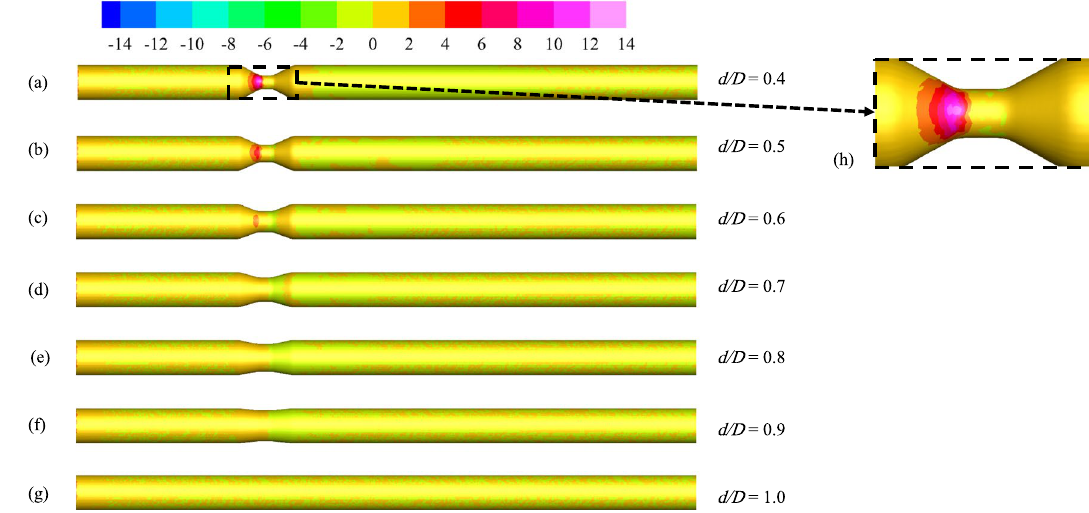
Fig. 9 The distribution of the WSS for case 1at different d/D , and (h) Zoomed in view for the WSS at vessel stenosis d/D = 0.4